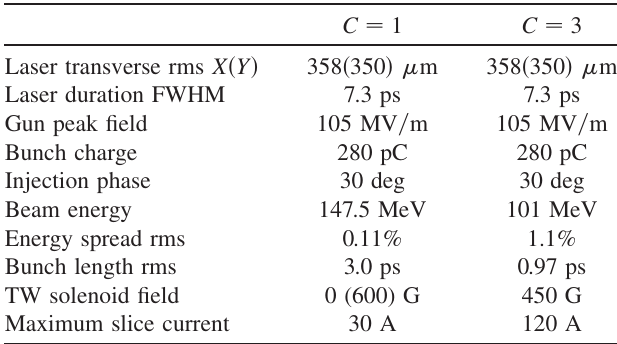
TABLE II. Comparison between uncompressed ( C ¼ 1 ) and compressed ( C ¼ 3 ) beam parameters for the 280 pC case.